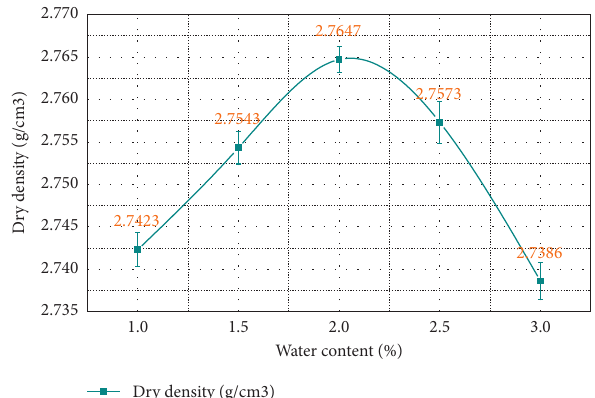
Figure 3: The relation between maximum dry density and water